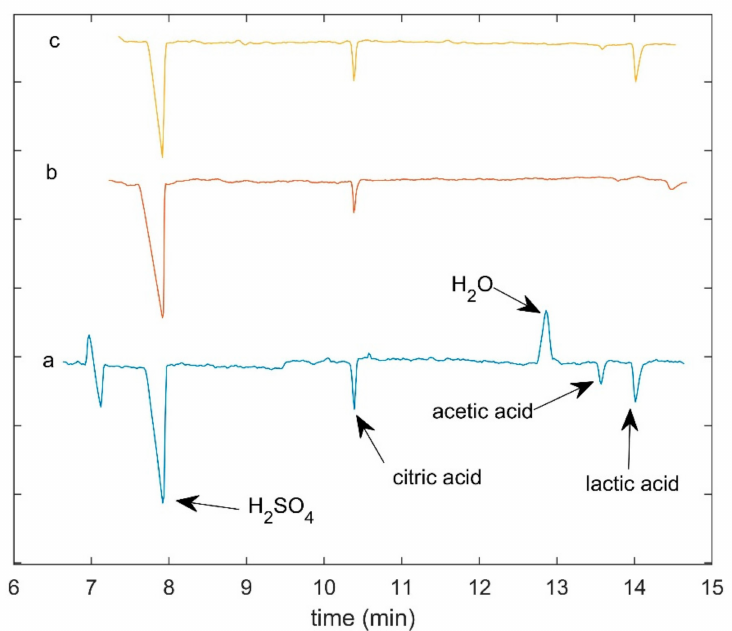
Figure 3. CE whey acids analysis: raw electropherograms of the first sampling point for each cheese type. ( a ) Grana type cheese; ( b ) Crescenza lab test; ( c ) Crescenza pilot